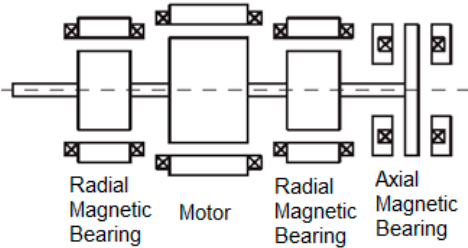
Figure 1. Structure of conventional magnetic bearing motor.